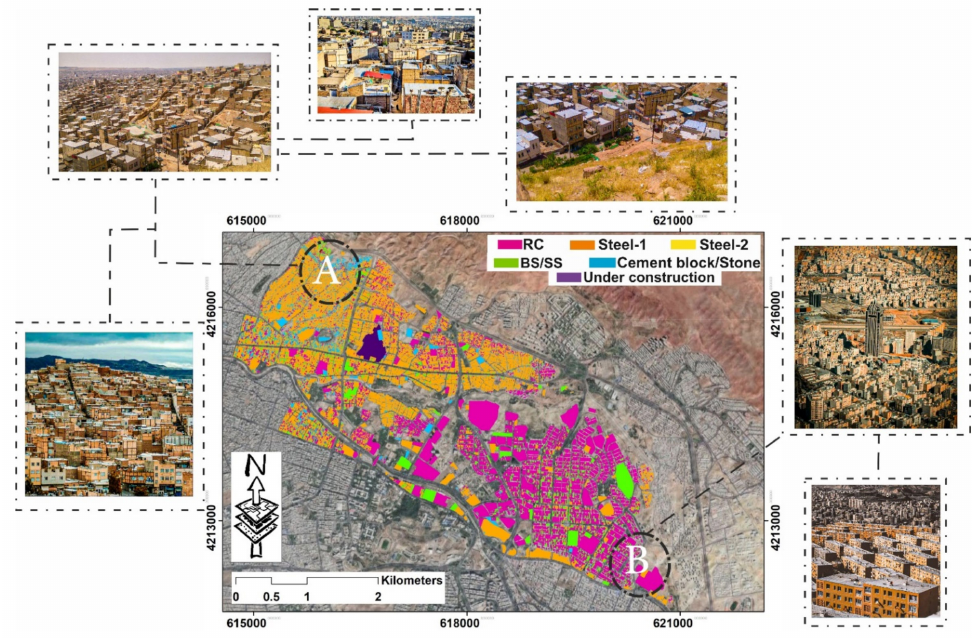
Figure 25. Status of District 1 of Tabriz. Table 7. Number of buildings damaged in terms of the level of destruction for the 1721